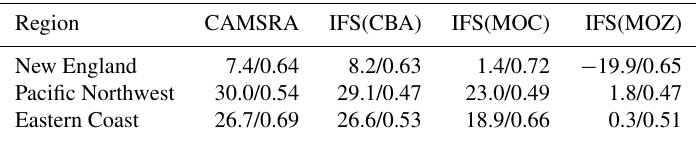
Figure 9. Comparisons of the daily variability of surface CO for 2014 against regional composites assembled from measurement sites participating in the AirNow network. Regions shown are the (a) Pacific Northwest and (b) US East Coast as determined by the number of available measurements for the rural classification. Table 8. Annual mean biases and Pearson’s R values for the comparison of simulations versus AirNow data. Unlike O 3 , most regions do not have enough CO stations designated as rural for a valid